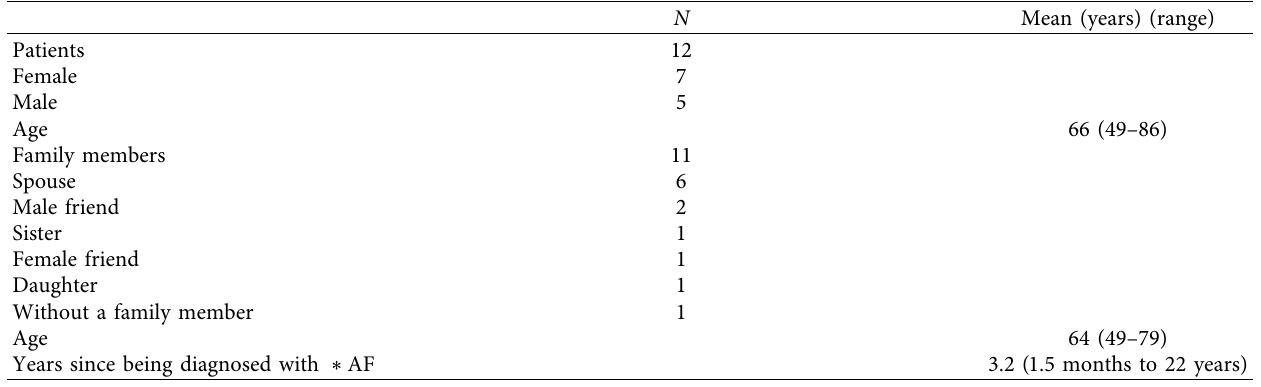
Table 1: Characteristics of patients and family members.